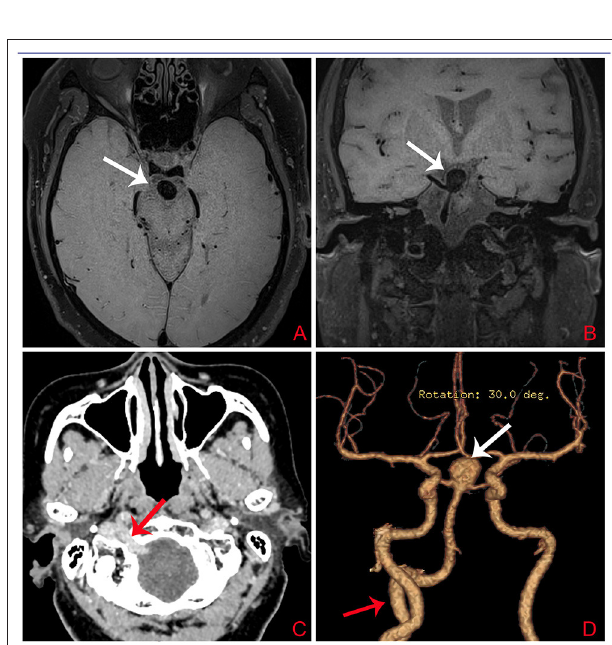
FIGURE 2 | (A,B) T1-weighted image (T1WI) showing an aneurysm at the bifurcation of the basilar artery (white arrow). (C) Computed tomography angiography demonstrating the PPHA (red arrow) entering the skull after traversing the hypoglossal canal. (D) Computed tomography angiography showing the PPHA (red arrow) originating from the right ICA and joining the BA. An aneurysm (white arrow) located at the bifurcation of the basilar artery is visible. PPHA, persistent primitive hypoglossal artery; ICA, internal carotid artery; BA, basilar